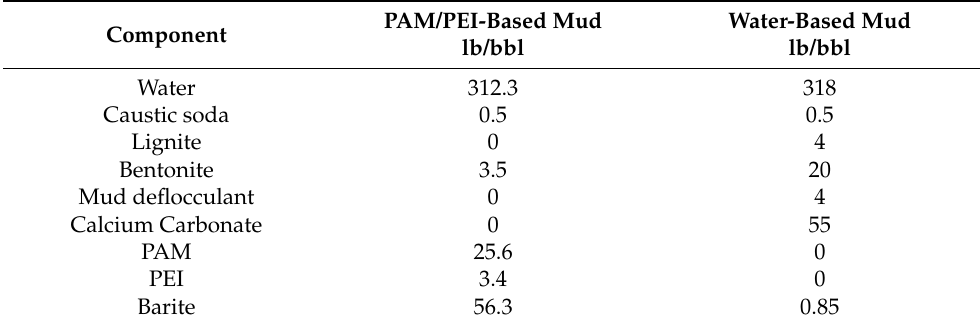
Table 5. Composition of the PAM/PEI-based mud and the water-based